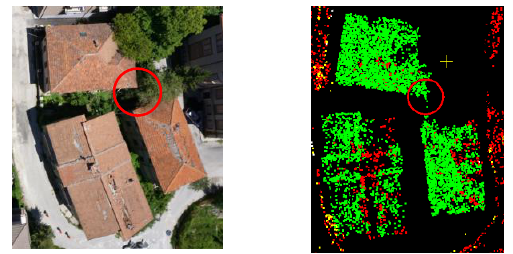
Figure 8 Details of 3 detected building roofs. Left nadir image; right sparse point cloud overlaid with the detected buildings - red circle indicates a segment which is part of the vegetation but is identified as part of a roof segment.